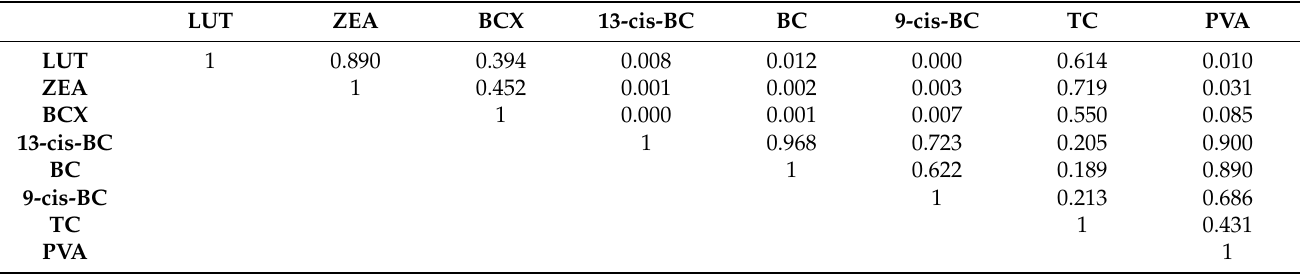
Table 4. Correlation coefficients between concentrations of individual carotenoid fractions in maize (N = 1857) samples determined by Ultra performance liquid chromatography